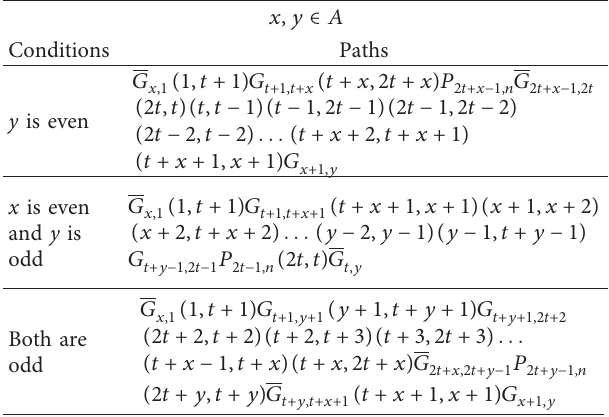
Figure 4: Five subsets of vertices. Table 2: Hamiltonian paths from 1 ≠ x to y in T when t is